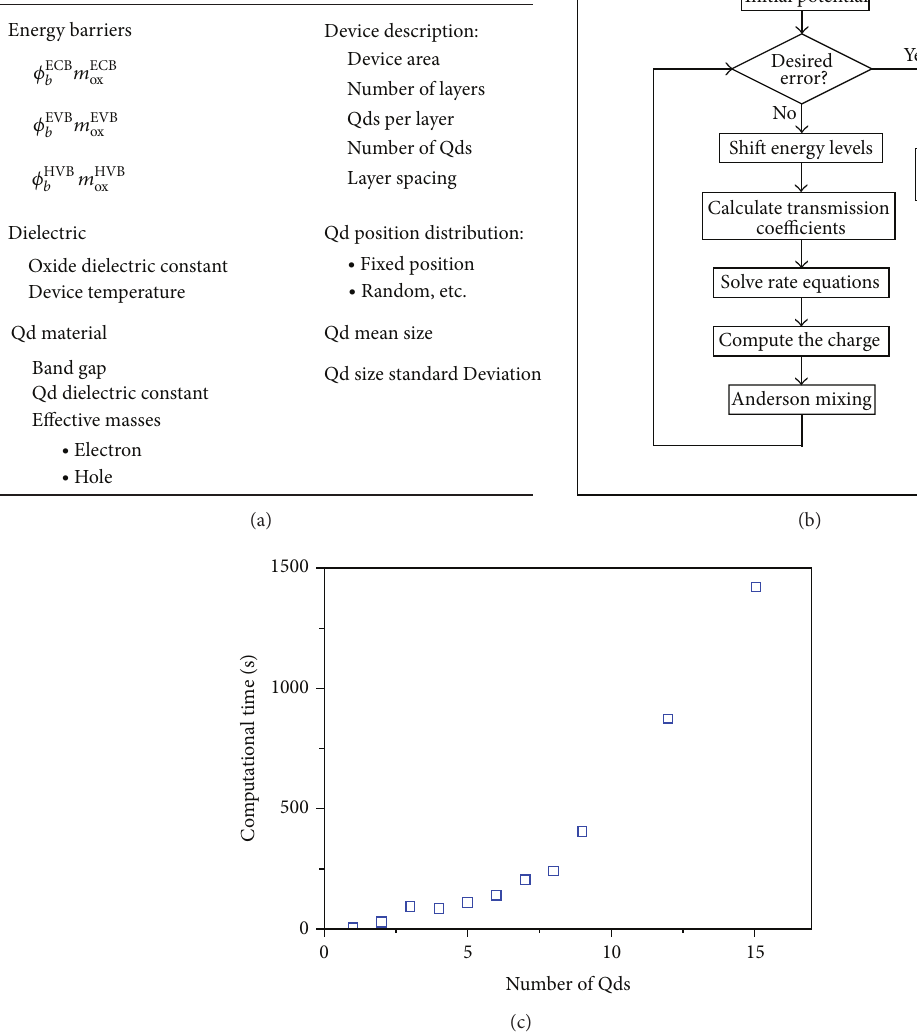
arrangement, and takes into account the material parame- ters needed to describe the Qds and the insulator